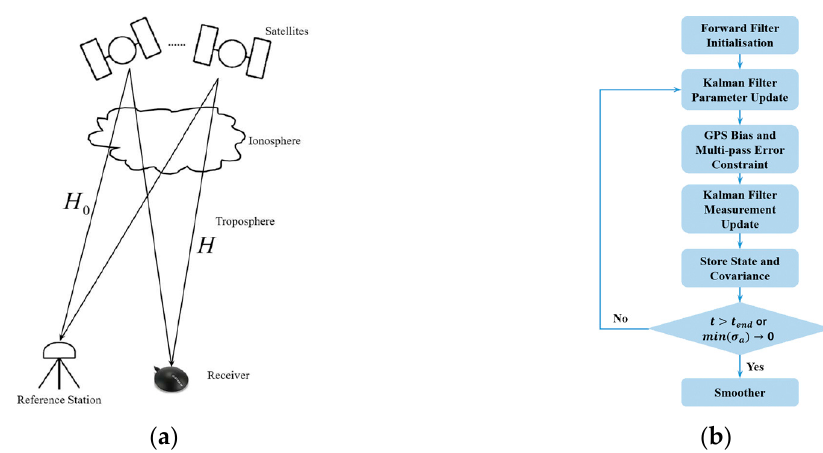
Figure 4. ( a ) The location of the GEONET stations in Japan; ( b ) location of the investigation site and nearest GEONET Station.